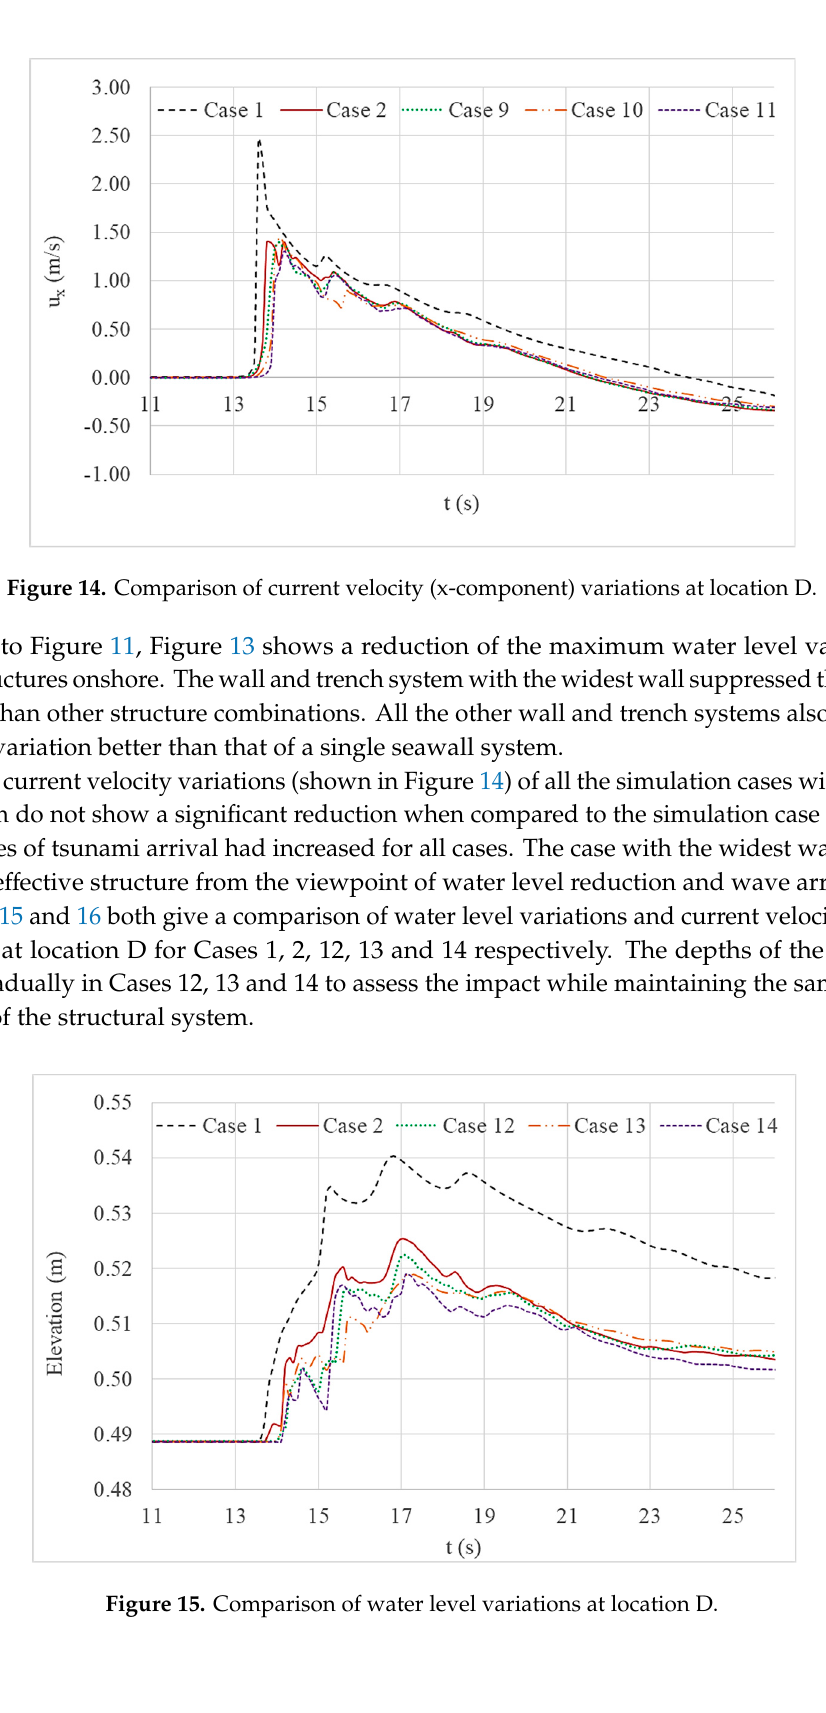
Figure 13. Comparison of water level variations at location D.